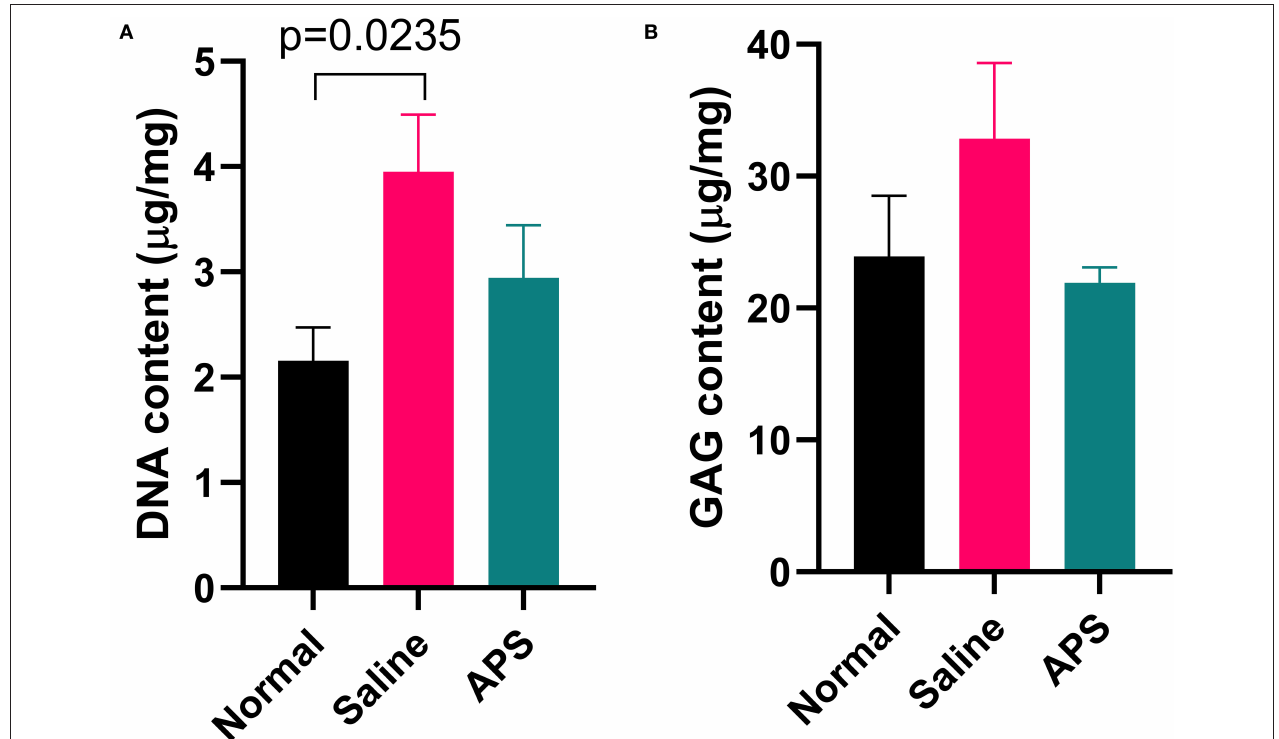
FIGURE 7 | Mean ( ± SEM) content of (A) DNA and (B) GAG of normal, saline treated, and APS treated tendon ( n =